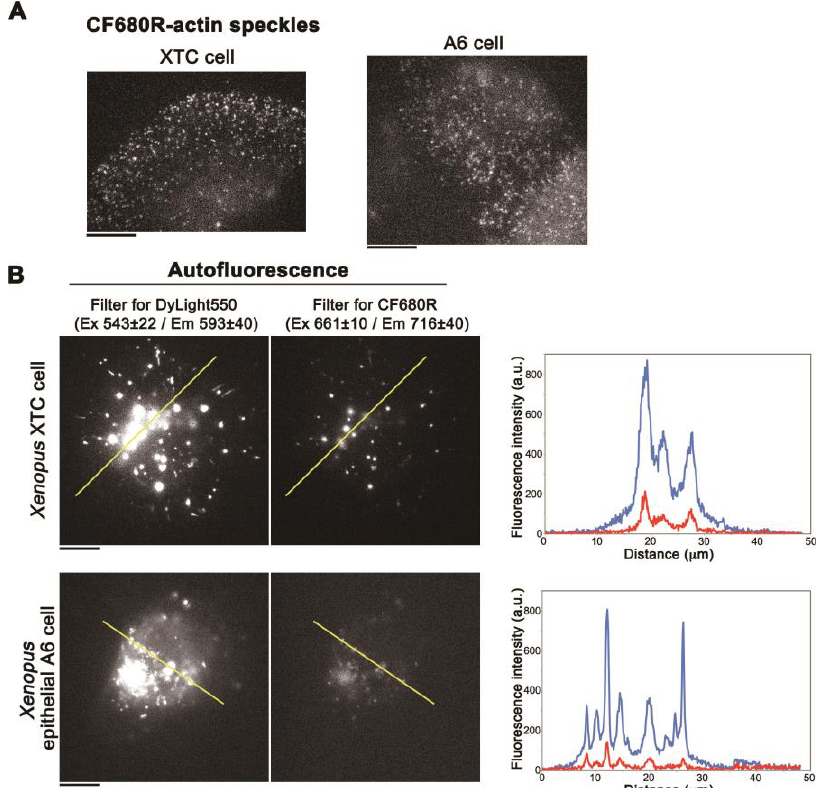
Figure 3. ( A ) Images of CF680R-actin SiMS in cell periphery of XTC cells (left) or A6 cells (right). The